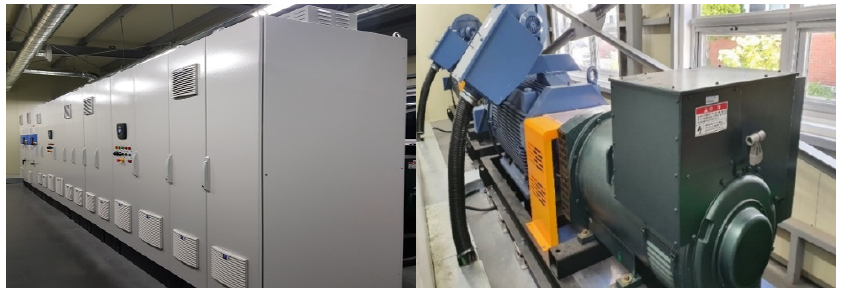
Figure 12. Drive unit with the propulsion system in testbed.